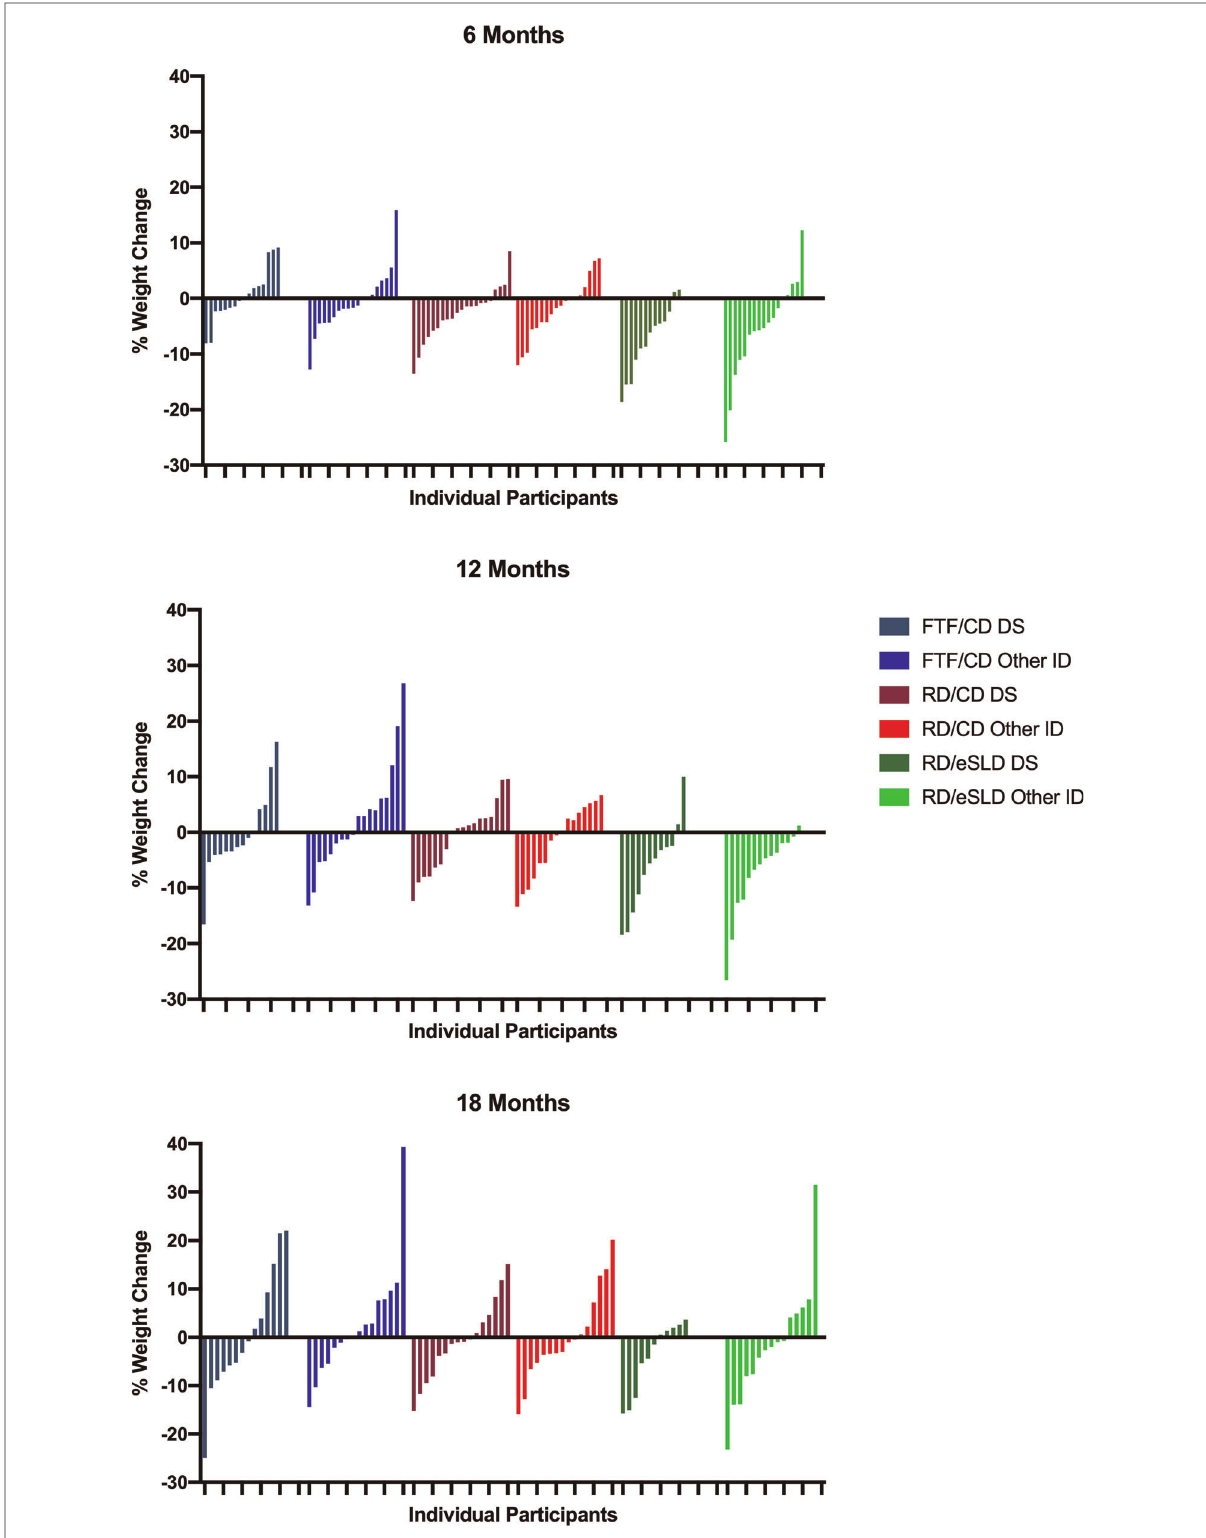
FIGURE 3 Individual percent weight change at 6, 12 and 18 months in adolescents with down syndrome (DS) or other intellectual disability (ID) by intervention